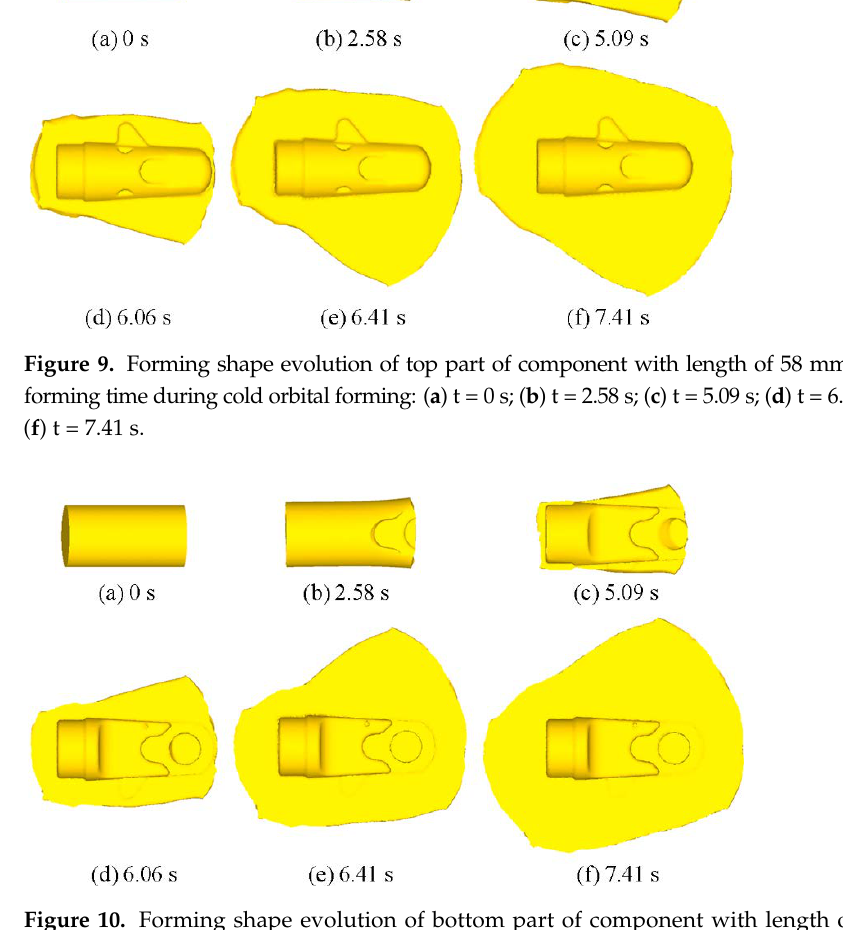
ly. In Figure 11, the distribution features of the component with different blank length 256 are almost same. When the forming finished, the effective strain was bigger at the boss 257 and the flash, while the effective strain was smaller in the other zone.